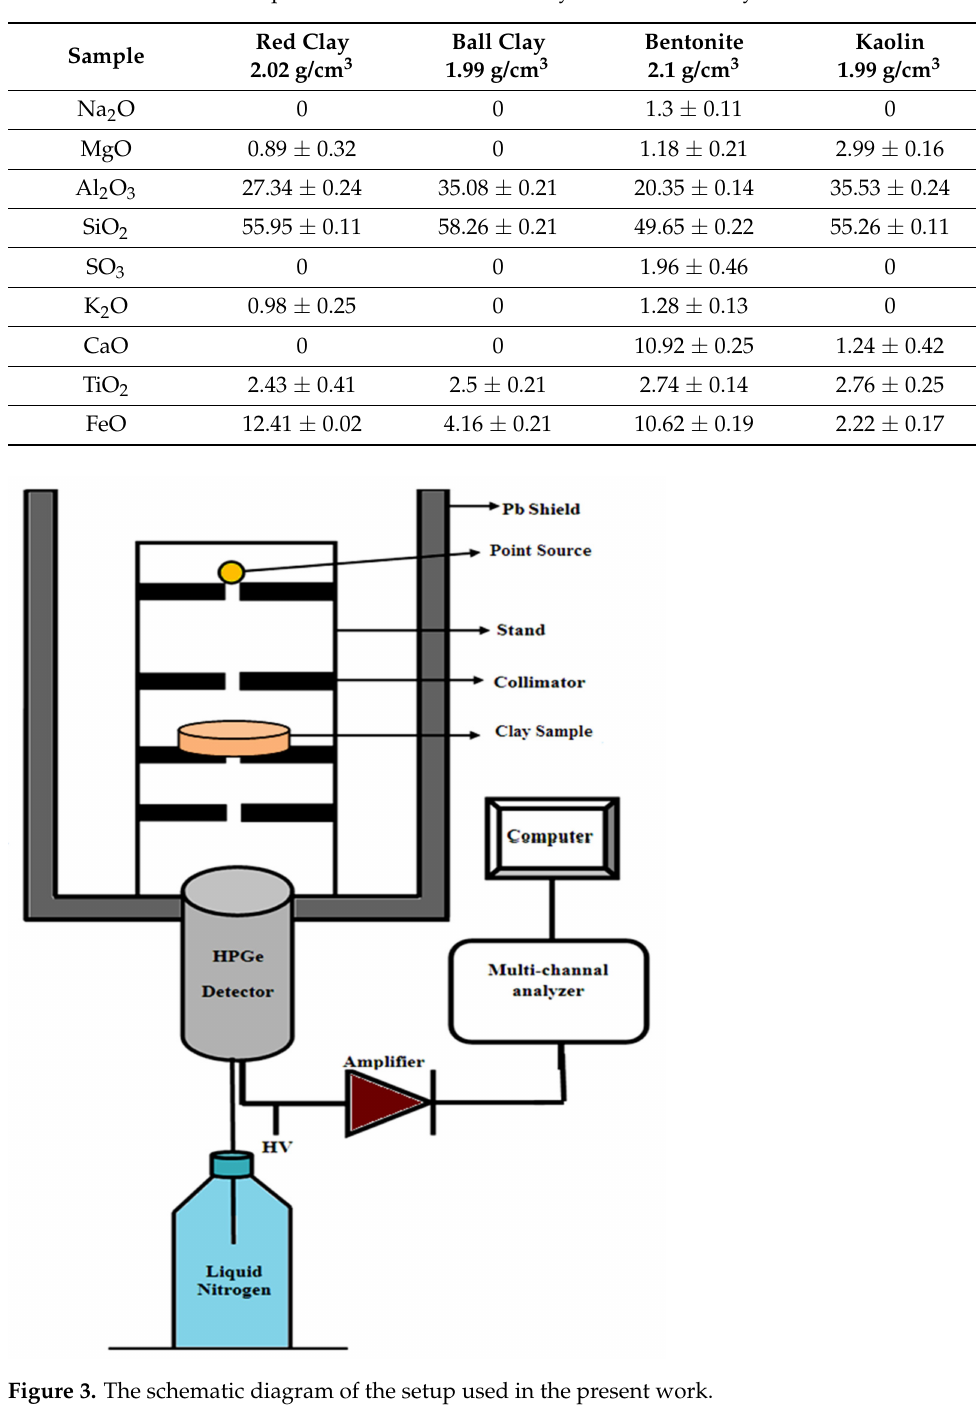
Table 1. The chemical compositions of four different clays and their density.